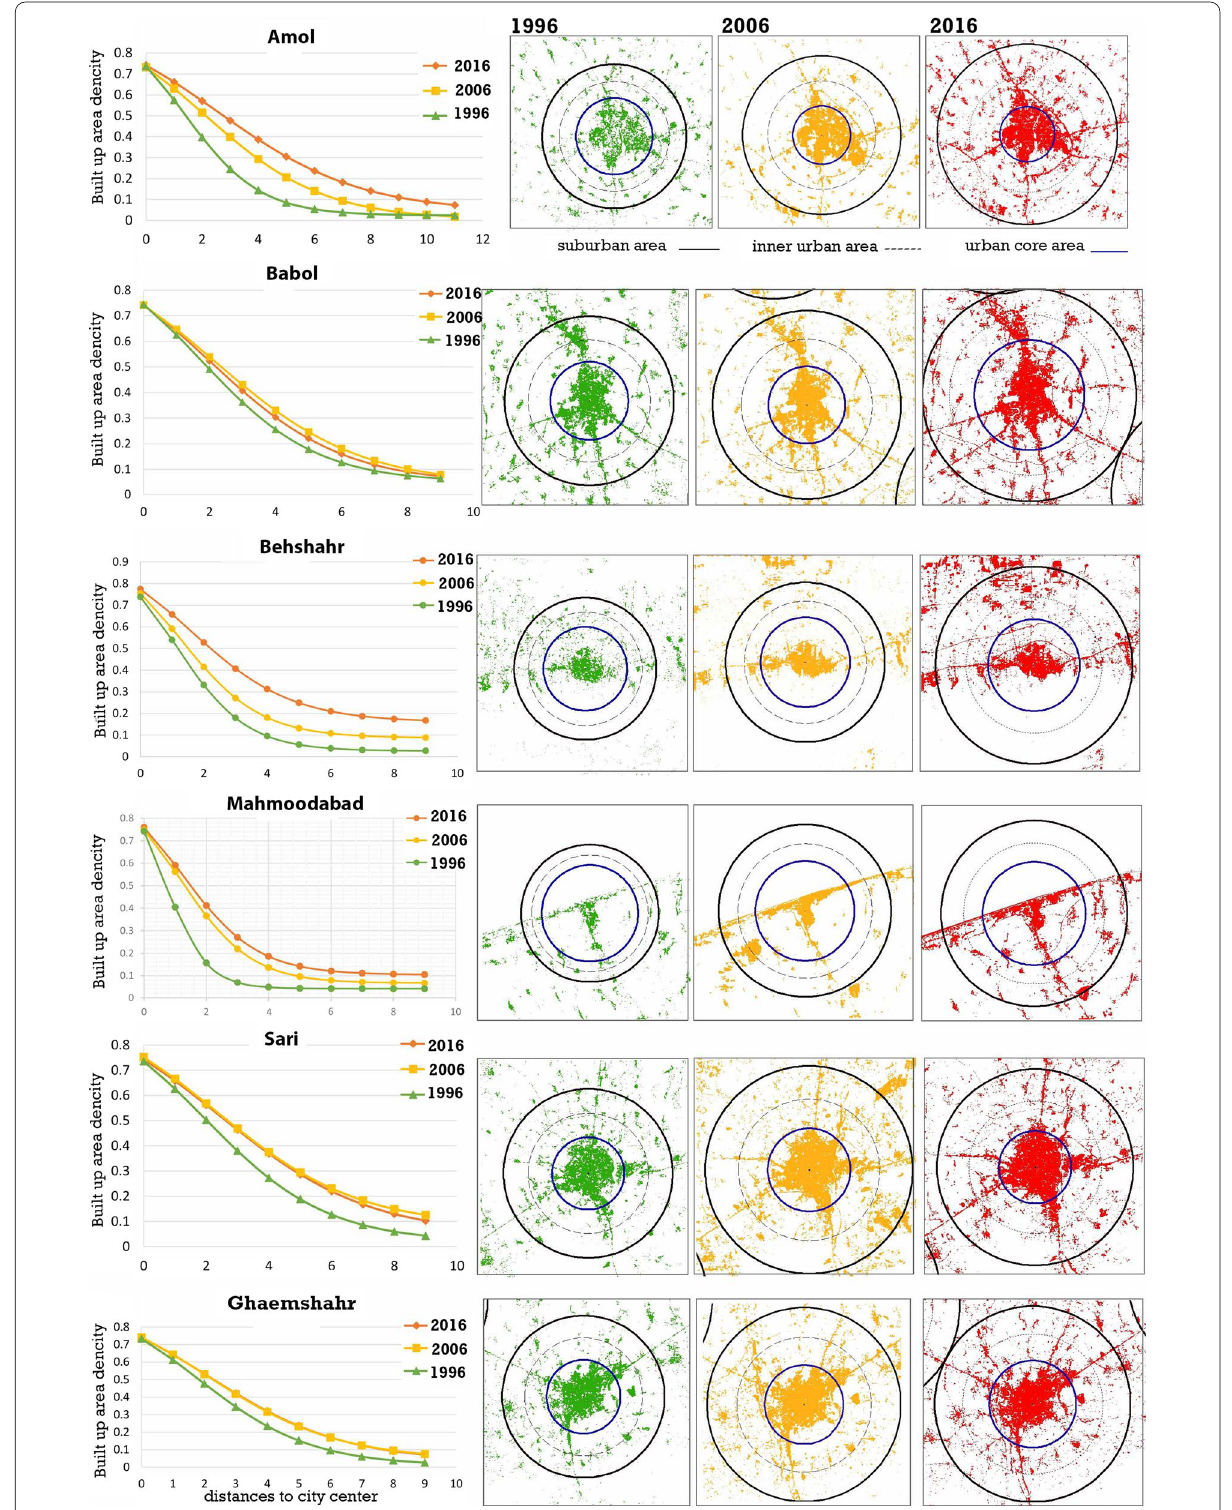
Fig. 4 Fitted distribution curves of the built-up areas in 1996, 2006, and 2016 and the expansion map of the built-up